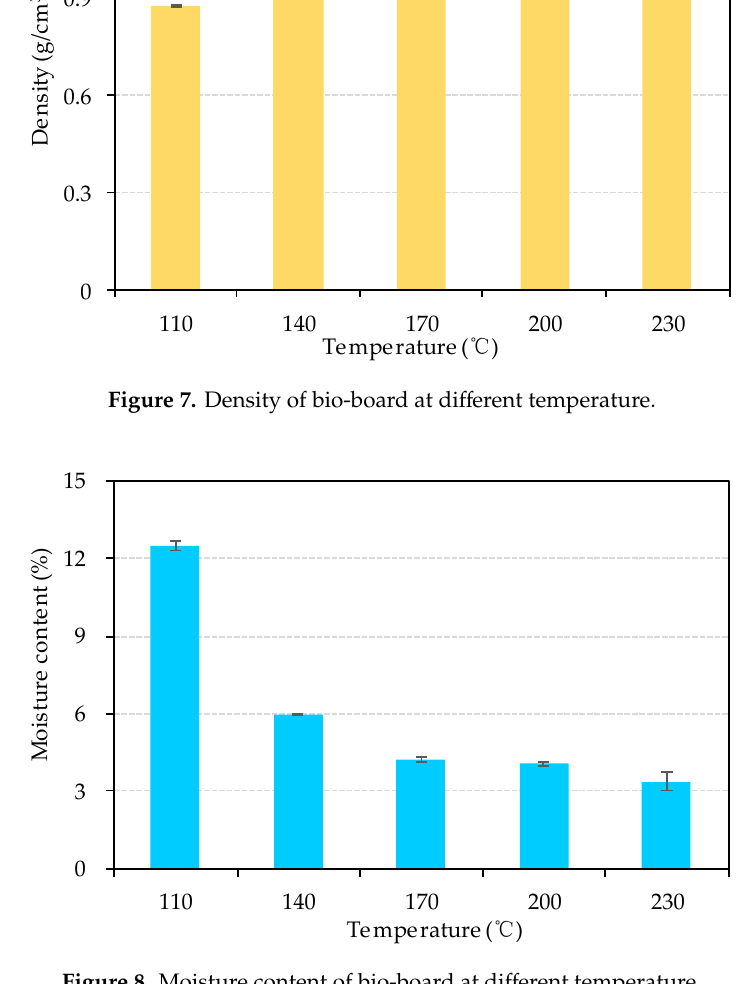
Figure 9. Tensile rupture stress of bio-board at different temperature (P < 0.05).